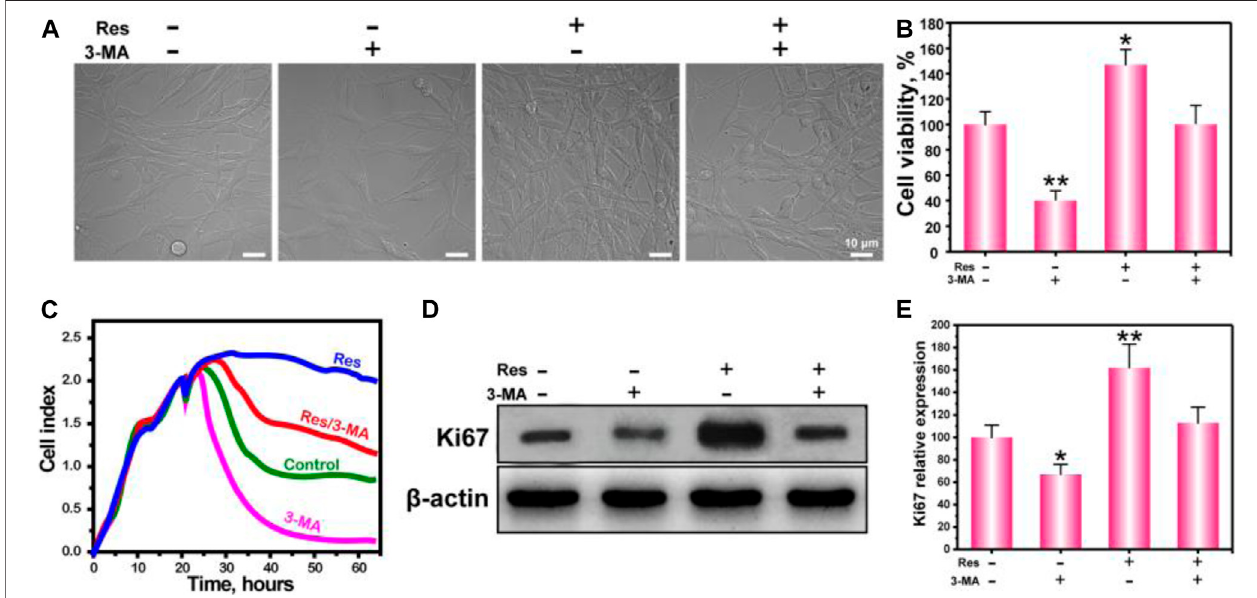
FIGURE2| ThebiomarkersCD29,CD44,CD34,andCD45wereidenti fi edby fl owcytometry (A) .Westernblotanalysistheexpressionofautophagycharacteristic proteins LC- Ⅰ , LC- Ⅱ , P62, and Beclin1 (B), and statistical analysis (C) , CLSM observation of the LC3 puncta (D), and ROS fl uorescence (E) in BMSCs treated with differentconcentrationsofRes(0,5,10,25,50 μ g/ml).Thevaluesarerepresentedasthemean ± SD( n (cid:1) 3).* p < 0.05and** p < 0.01vscontrolgroup(Resconcentration is 0 μ